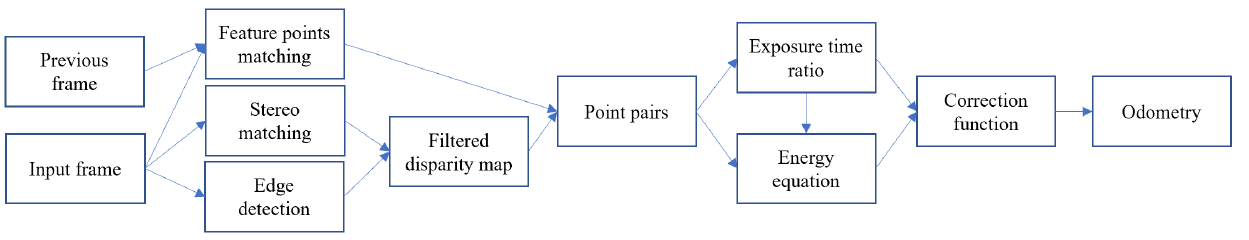
Figure 1. Flow chart of the process of the proposed